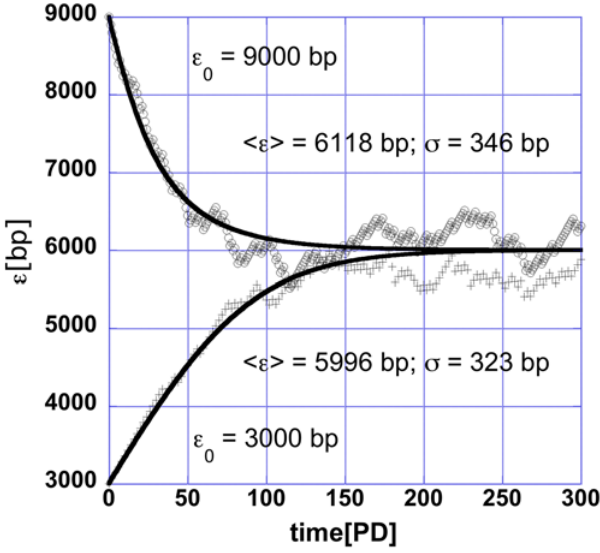
Figure 1. In this figure the time dependence (in cell divisions) of the average telomere length e is shown. Because the initial length of the two representative telomeres shown in the figure is longer (shorter) than the homeostatic length the telomeres gradually approach the homeostatic length. Adaptive control at the telomere guarantees that short telomeres are extended and long telomeres are shortened to the average homeostatic length. The initial telomere length, the average steady state telomere length and the square root of the variance are shown for two telomeres in the presence of telomerase. While at the steady state, the square root of the variance is small compared to the average telomere length. As the telomere shortens below 1000 bp these two quantities will become comparable and large fluctuations may produce a sub-critically short telomere and trigger p53 independent checkpoint response. The continuous model is shown with continuous lines.